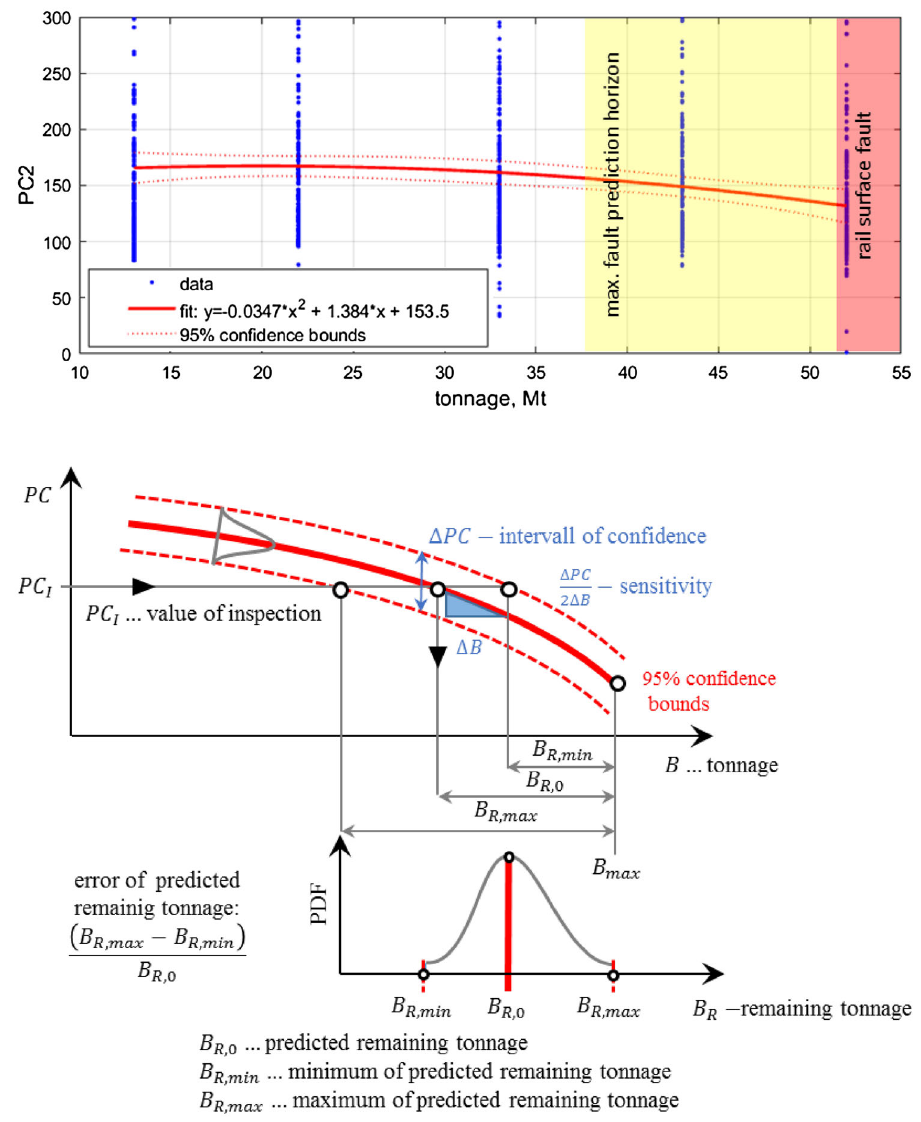
Fig. 15 The regression of Pc2 values versus the frog’s lifetime